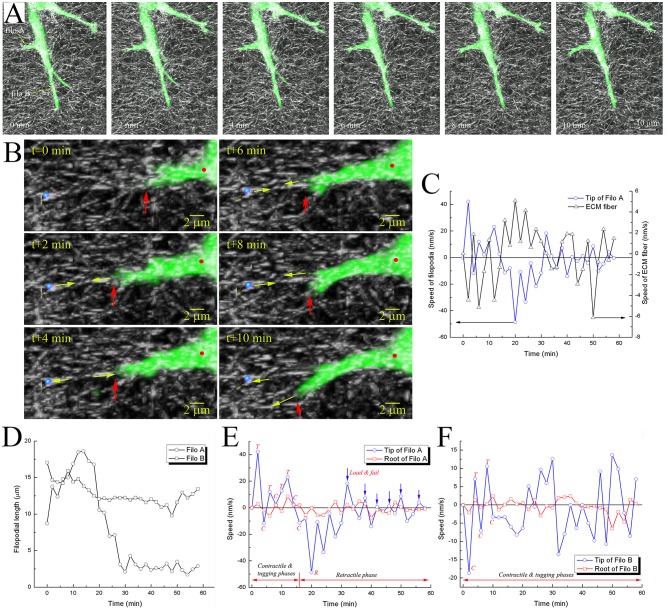
Experimental observations of filopodia state changes during penetration.
A) 3-D confocal images showing filopodia protrusive, tugging, and contractile motions in GFP-transfected HUVECs, and remodeling of collagen fiber network at time points of 0, 2, 4, 6, 8 and 10 minutes. B) 3D collapsed images showing the crawling behavior of filopodial tip at time points 0, 2, 4, 6, 8 and 10 minutes. Blue sphere indicates a monitored location on the ECM, which was shown to be mechanically linked to the filopodial tip. Yellow arrows indicate directions of displacements of the blue sphere and the filopodial tip. Red arrows and red dots indicate filopodial tips and roots, respectively. C) Graph showing temporal variations of speeds at the tip of filopodium (Filo A in A) and blue sphere in B). D) Graphs showing filopodial length changes in Filo A and B over time. Graphs in E) and F) showing temporal variations in speedsn at both tip and root of the two filopodia: Filo A in E) and Filo B F). Note that plus and minus signs represent forward and backward movements of filopodium, respectively, and blue arrows in E) indicate fast oscillatory ‘load-and-fail’ traction dynamics during the retractile phase. T, C, and R in E) and F) indicate tugging, contractile, and retractile phases, respectively.